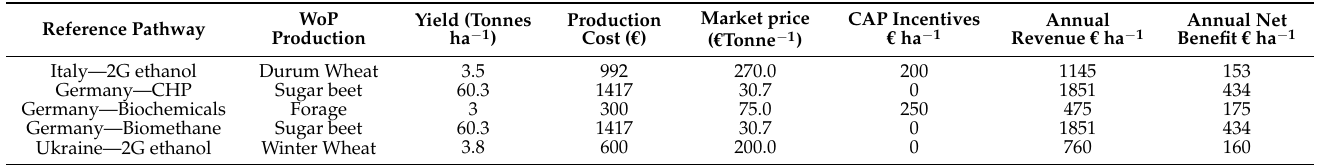
Table 4. Reference scenarios (WoP) considered for the